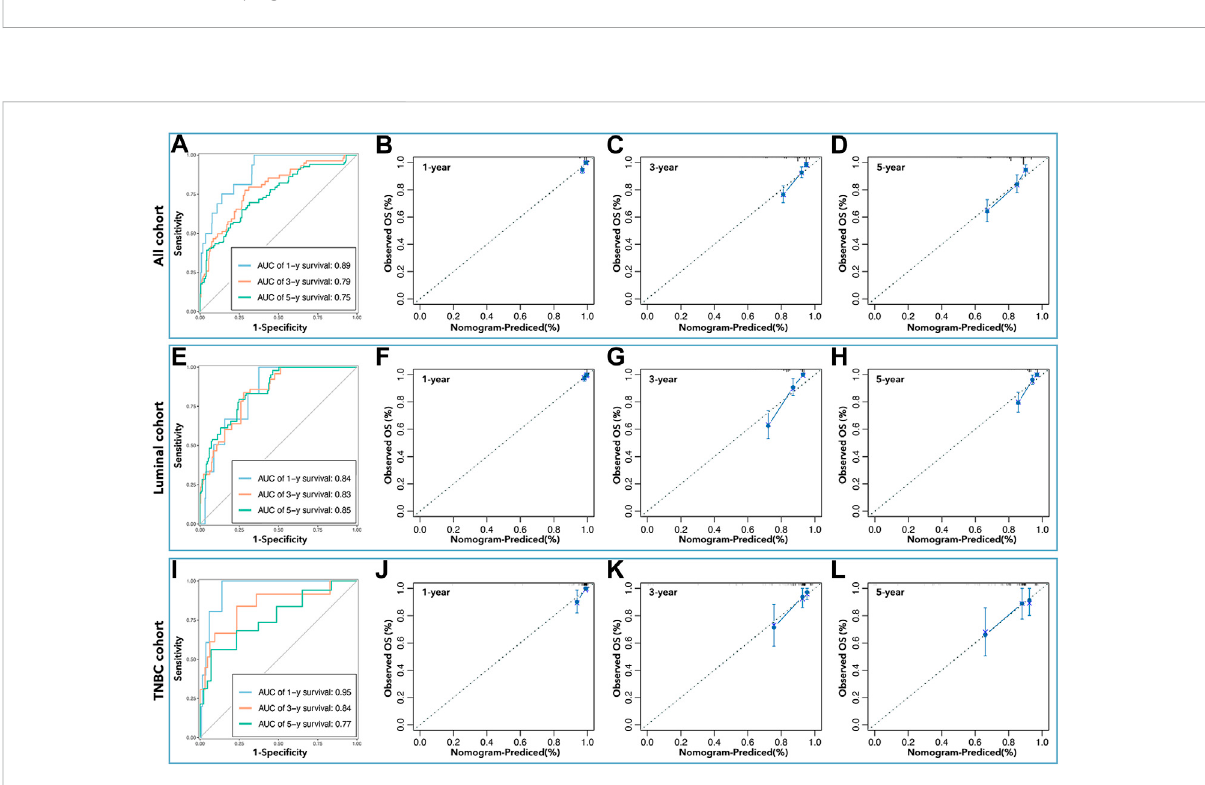
FIGURE 10 Inner veri fi cation of nomograms. The AUC values of nomograms in all cohorts (A) were 0.89 (1 year), 0.79 (3 years), and 0.75 (5 years), in the luminal cohort (E) were 0.84 (1 year), 0.83 (3 years), and 0.85 (5 years), and in theTNBC cohort (I) were0.95 (1 year), 0.84 (3 years), and 0.77 (5 years). Calibration analysis was performed to assess the prediction accuracy of nomograms in all cohorts (B – D) , the luminal cohort (F – H) , and the TNBC cohort (J – L)